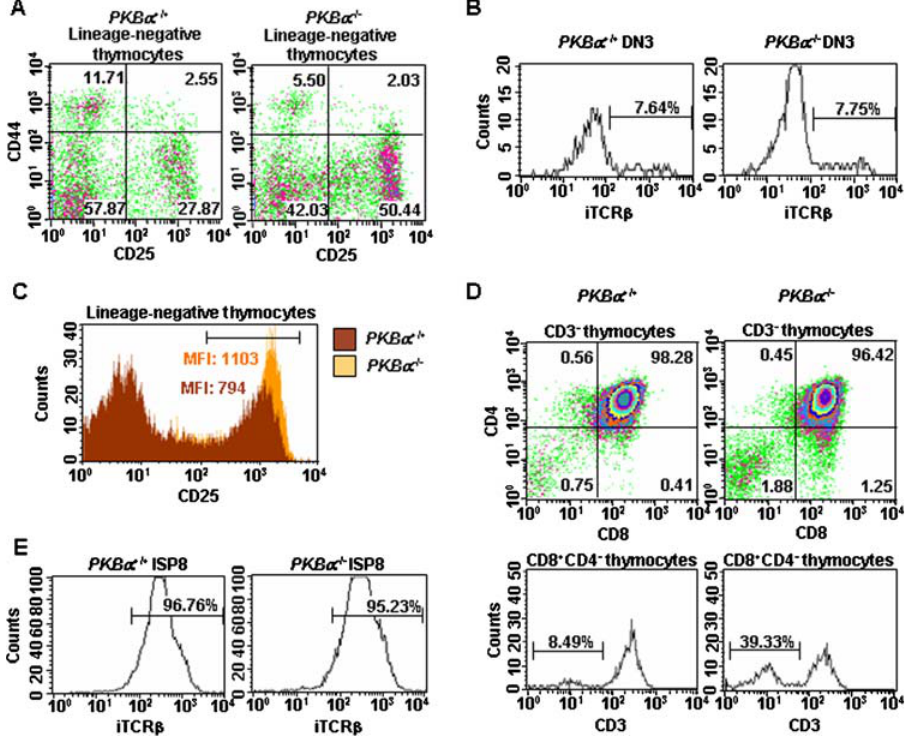
Figure 3. The lack of PKB a leads to an accumulation of DN3 and ISP8 early thymocyte subsets. Flow cytometric analysis of early thymocytes at the transition from DN to DP. A: Density plots show thymocytes from PKB a + / + and PKB a 2 / 2 mice that were stained with cell surface markers for identification of lineage-negative thymocytes DN1 (CD25 2 CD44 + ), DN2 (CD25 + CD44 + ), DN3 (CD25 + CD44 2 ), and DN4 (CD25 2 CD44 2 ). B: Histograms show the intracellular protein expression of TCR b (iTCR b ) in DN3 thymocytes from PKB a + / + and PKB a 2 / 2 mice. C: Histograms show the surface expression of CD25 on lineage-negative PKB a + / + and PKB a 2 / 2 thymocytes. MFI: mean fluorescence intensity. D: Density plots and histograms show thymocytes from PKB a + / + and PKB a 2 / 2 mice that were labeled with cell surface markers for identification of ISP8 (CD4 2 CD8 + CD3 2 ) thymocytes. E: Histograms show the intracellular protein expression of TCR b (iTCR b ) in ISP8 thymocytes from PKB a + / + and PKB a 2 / 2 mice. The results shown are representative of 3 independent experiments on 4 to 6 week-old mice. n $ 4 (n=number of mice per genotype within the same